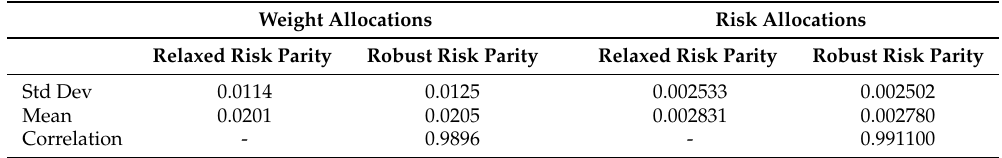
Table 11. Summary Statistics of Relaxed Risk Parity versus Robust Risk